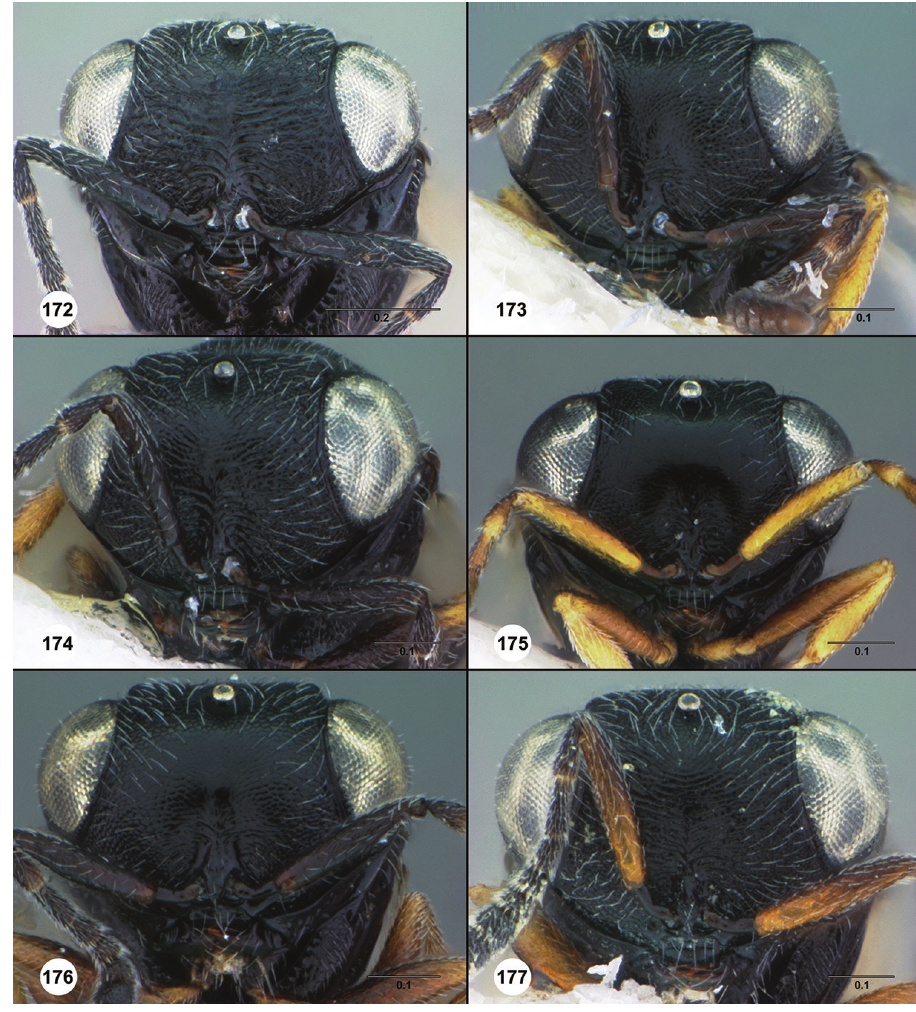
Figures 172–177. T. semistriatus 172 female (USNMENT00896318), head, anterior view 173 female (USNMENT00896062), head, anterior view 174 female (USNMENT00896262), head, anterior view 175 female (USNMENT00896226), head, anterior view 176 female (USNMENT00896205), head, anterior view 177 female (USNMENT00896254), head, anterior view. Scale bars in